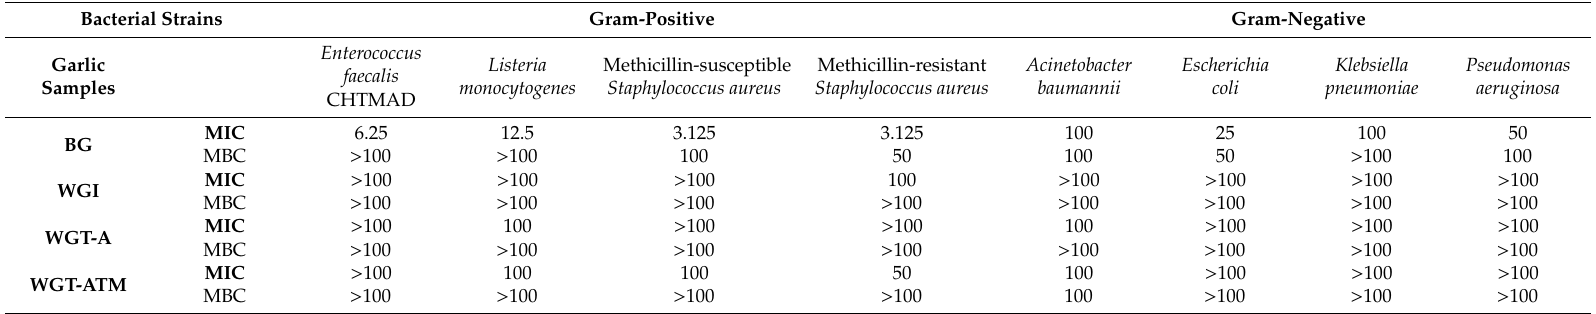
Table 4. Antimicrobial activity of A. sativum